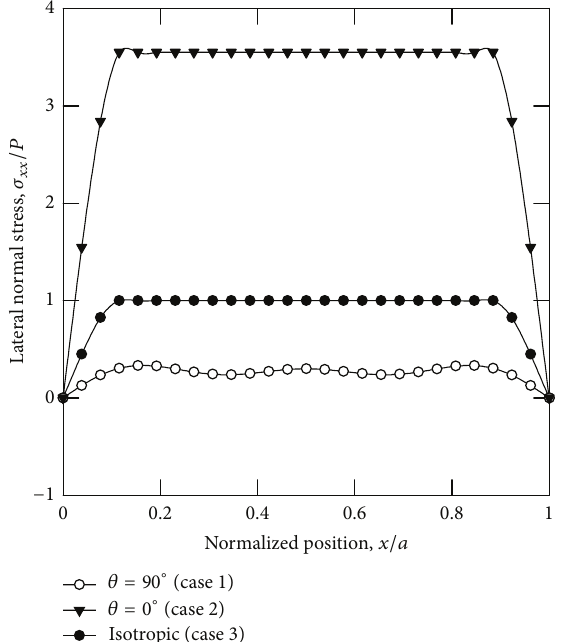
Figure 4: Effect of fiber orientation and material isotropy on the normalized lateral stress component at the section 𝑦/𝑏 = 1.0 of the